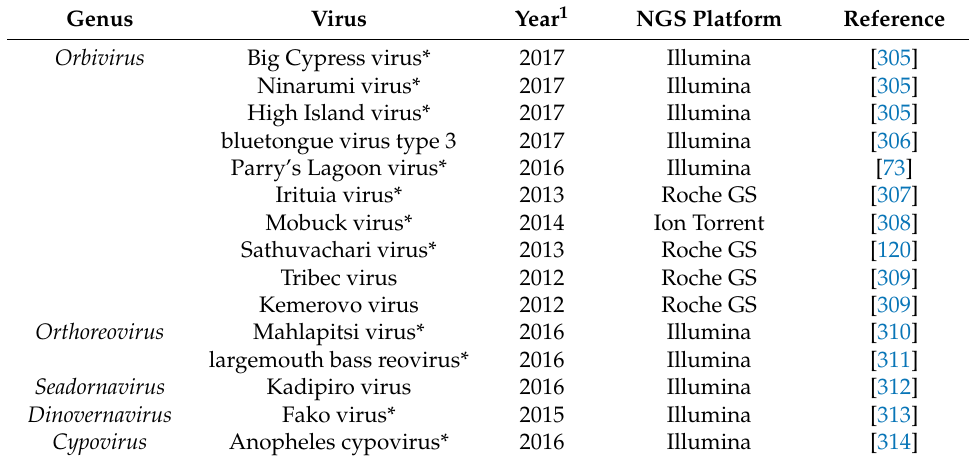
Table 1. Novel reoviruses identified recently using various next generation sequencing (NGS)